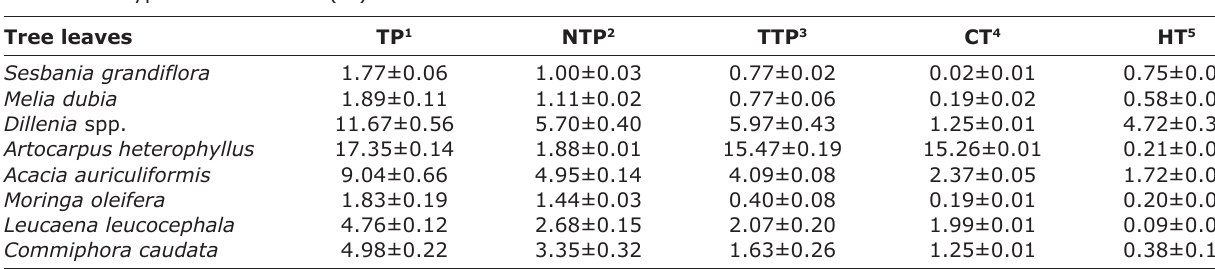
Table-2: Polyphenolic fractions (%) of tree leaves on DMB. Tree